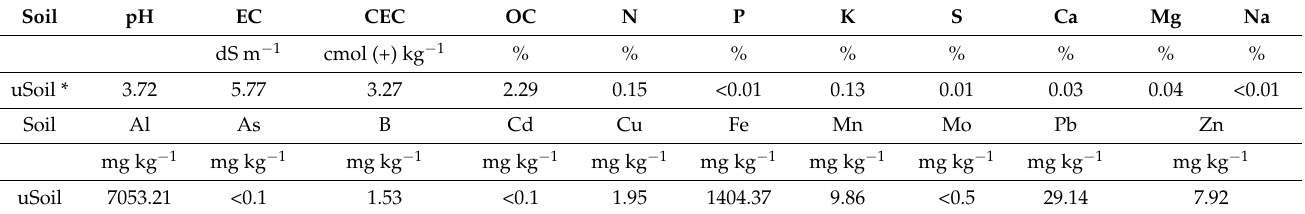
Table 2. Chemical properties of uncontaminated sandy soil (<2 mm fraction) collected from Cleland Conservation Park, Mt Lofty, South